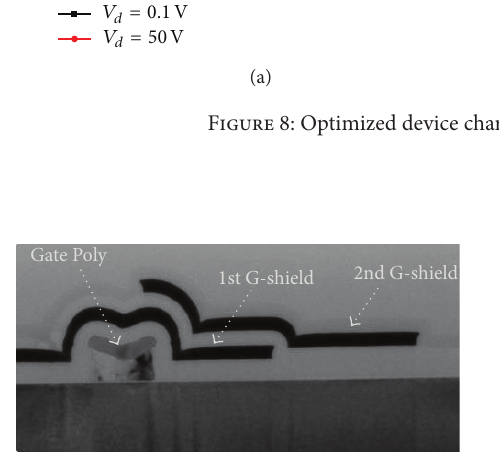
Figure9:TEMpictureoftheoptimizeddoubleG-shieldRFLDMOS